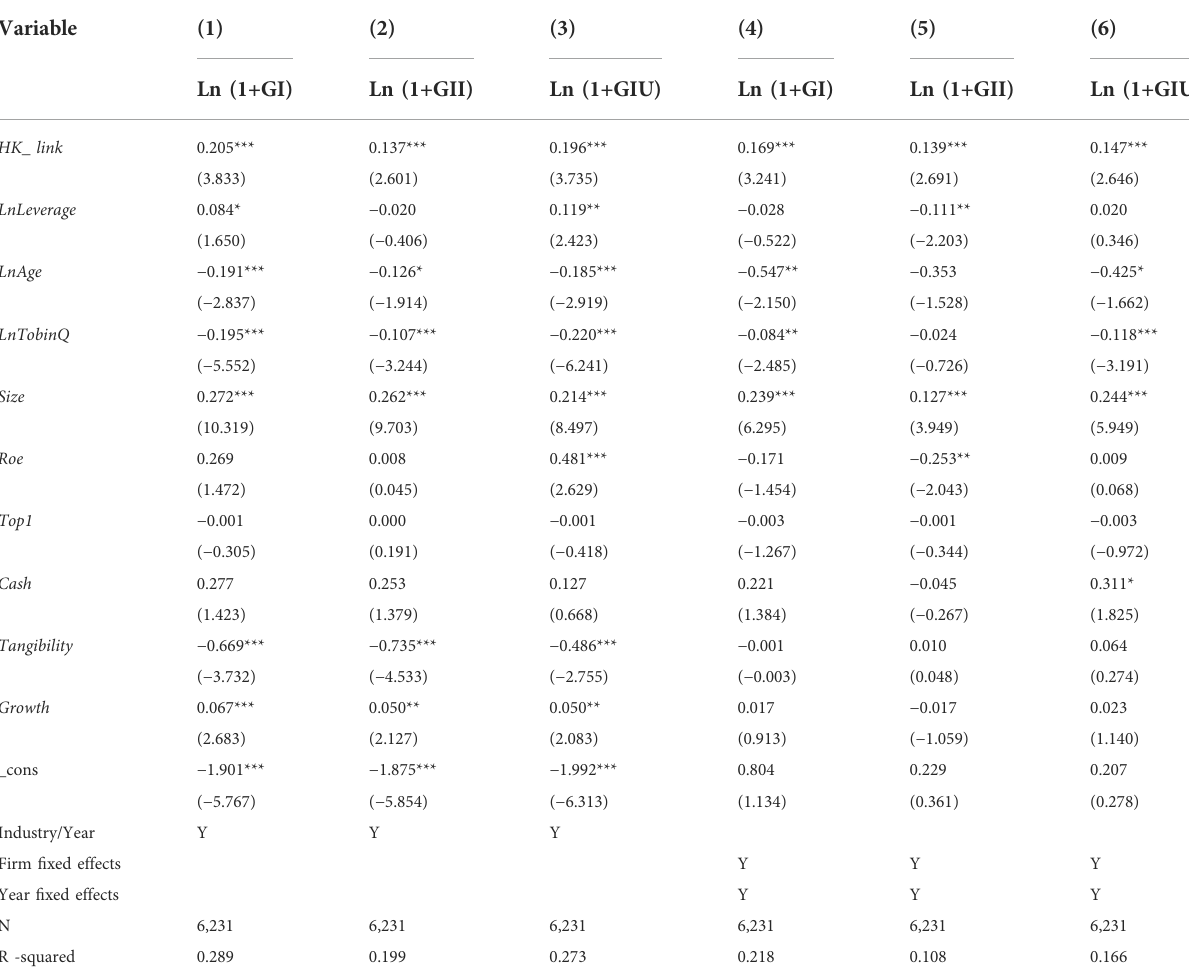
TABLE 9 Other robustness